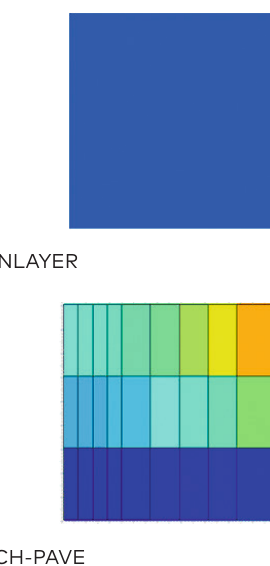
Figure 11. The distribution of the resilient modulus in the subgrade at the end of the